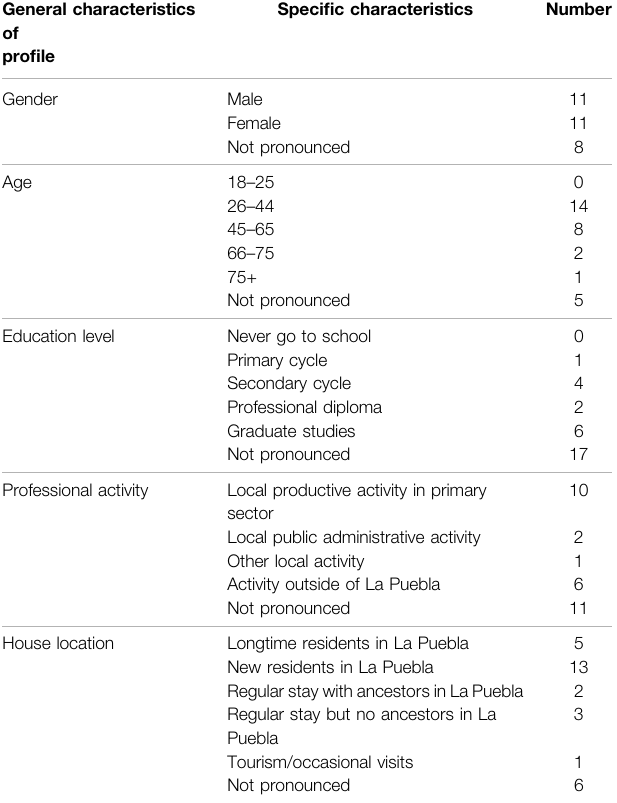
TABLE 6 | Repartition of the interviewee pro fi le.